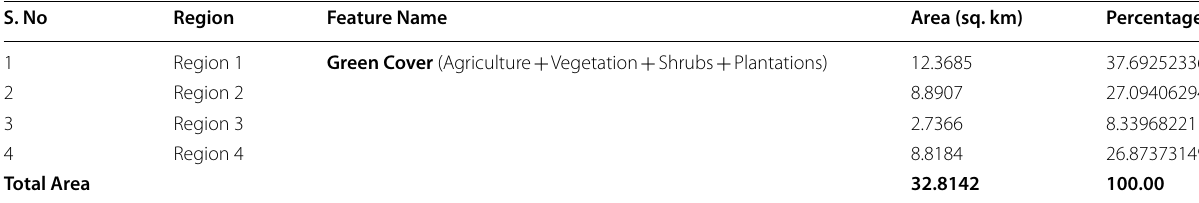
Table 9 Distribution of green spaces across a selected area